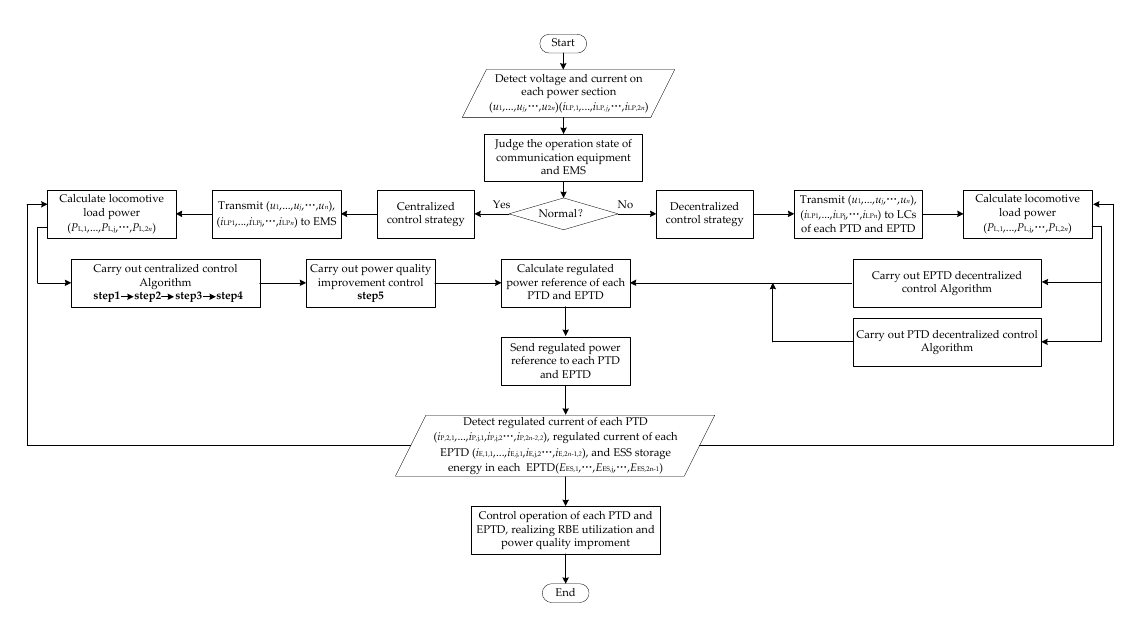
Figure 20. Flow chart of centralized-decentralized control.